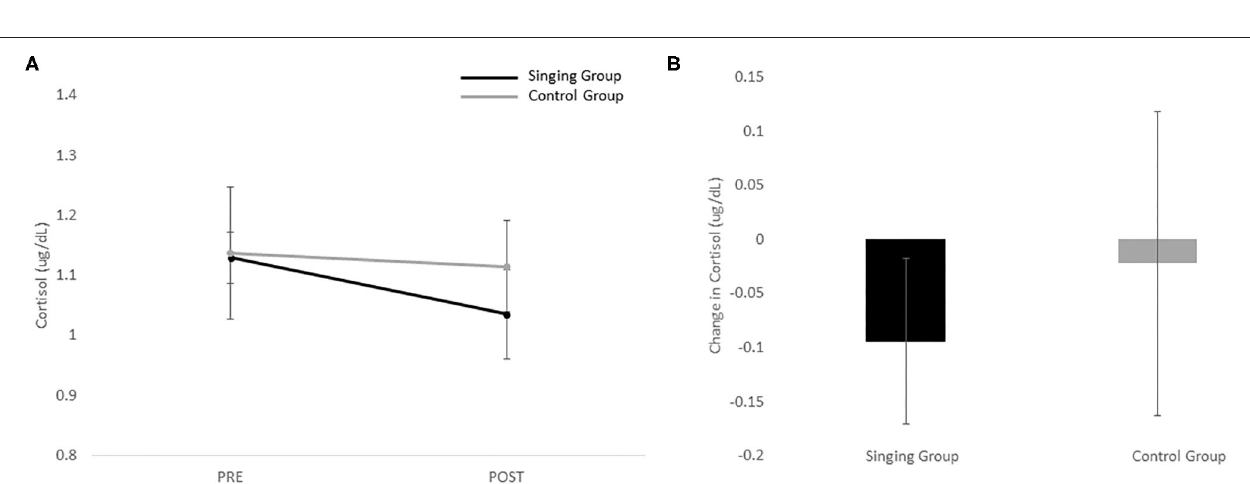
FIGURE 2 | (A) Pre and post-values for the singing and control group for cortisol. (B) Change in cortisol for both the singing and control groups.